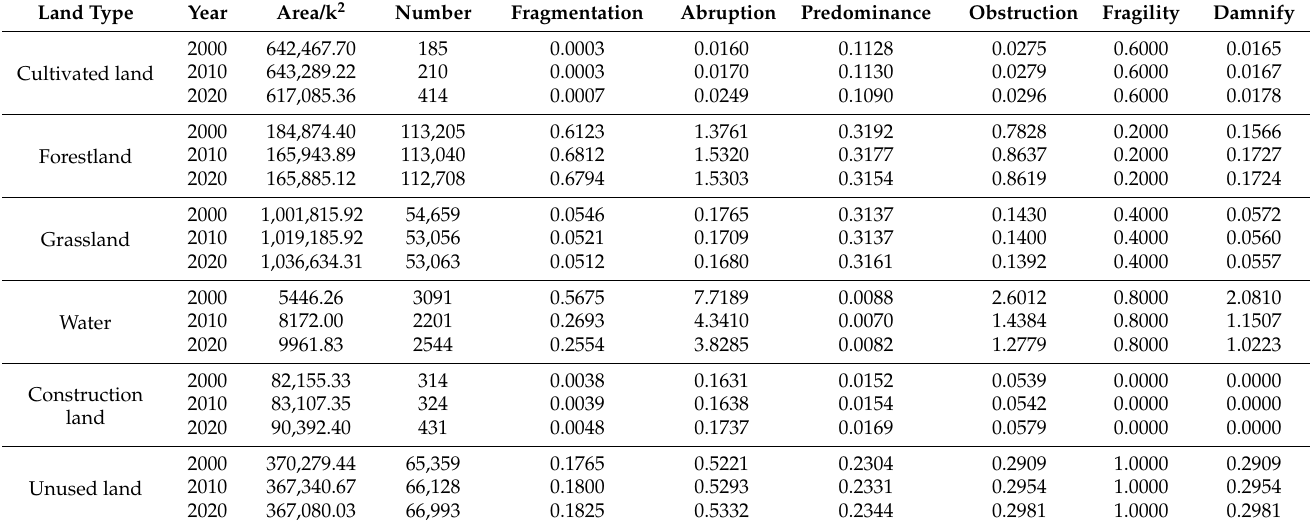
Table A3. Landscape pattern index of Chuy State from 2000 to 2020.